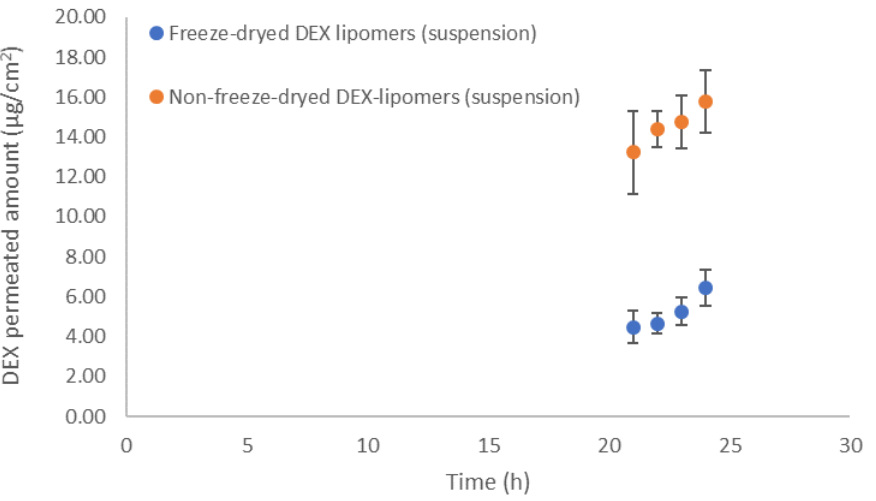
Figure 8. Transdermal DEX (lipomers before and after lyophilization) profile in dermatomed pig skin ( n = 6). The results show the mean and standard deviation. Table 9. Permeation parameters of nanoparticles before and after